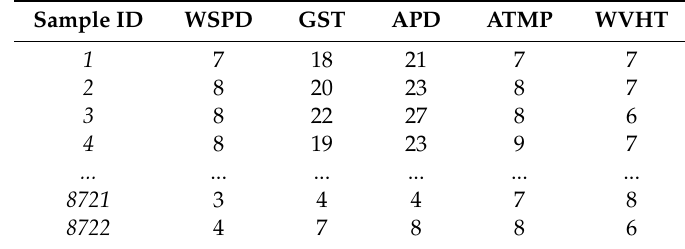
Table 5. Discrete training